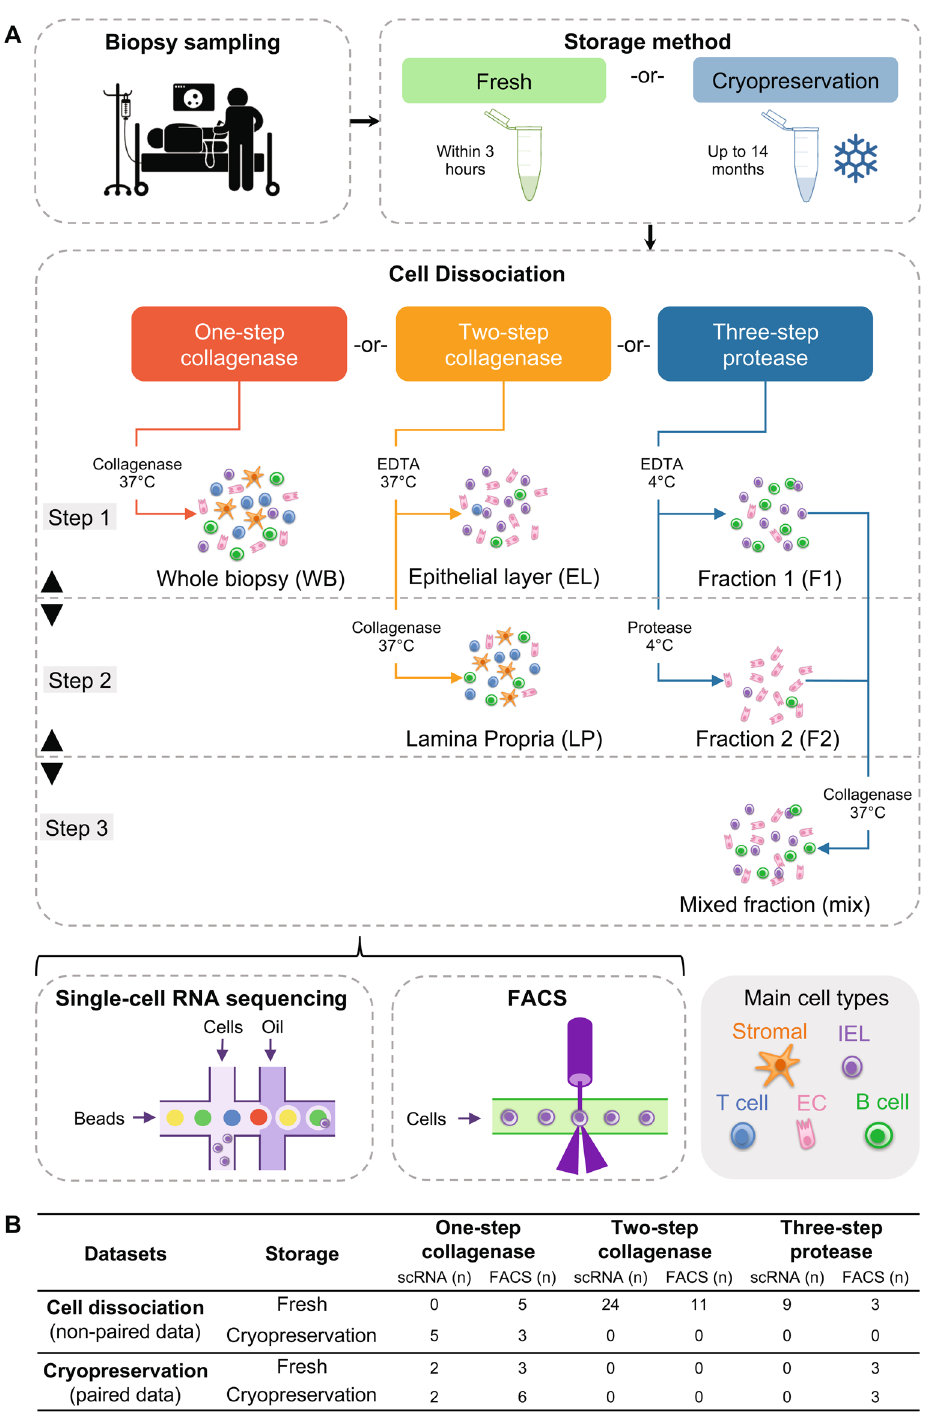
Figure 1. Study overview and datasets. ( A ) Schematic representation of the study set-up. Biopsies were sampled, either used fresh or cryopreserved, and dissociated using the one-step collagenase protocol with collagenase at 37 °C; the two-step collagenase with EDTA in step 1 and collagenase at 37 °C in step 2; or the three-step protease protocol, starting with 4 °C EDTA incubation in step 1, protease digestion in step 2, and a short collagenase digestion at room temperature in step 3. ( B ) Two datasets were generated to investigate: 1. the effect of cryopreservation and 2. the effect of different dissociation protocols on cell-type viability, composition, transcriptome, and functionality. IEL, intraepithelial cell; EC, epithelial cell. Colonoscopy pictogram was drawn by Gan Khoon Lay, https:// theno unpro ject. com/ term/ colon oscopy/ 12502